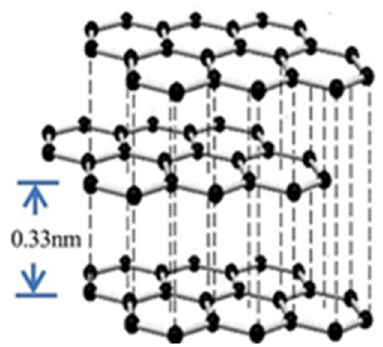
Figure 3. Schematic diagram of graphite.